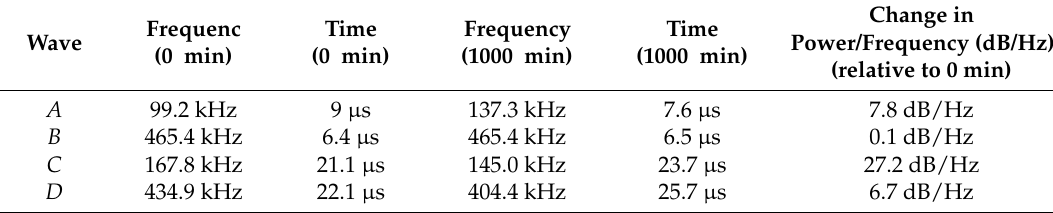
Table 2. Oval Specimen (Near): Wave information.